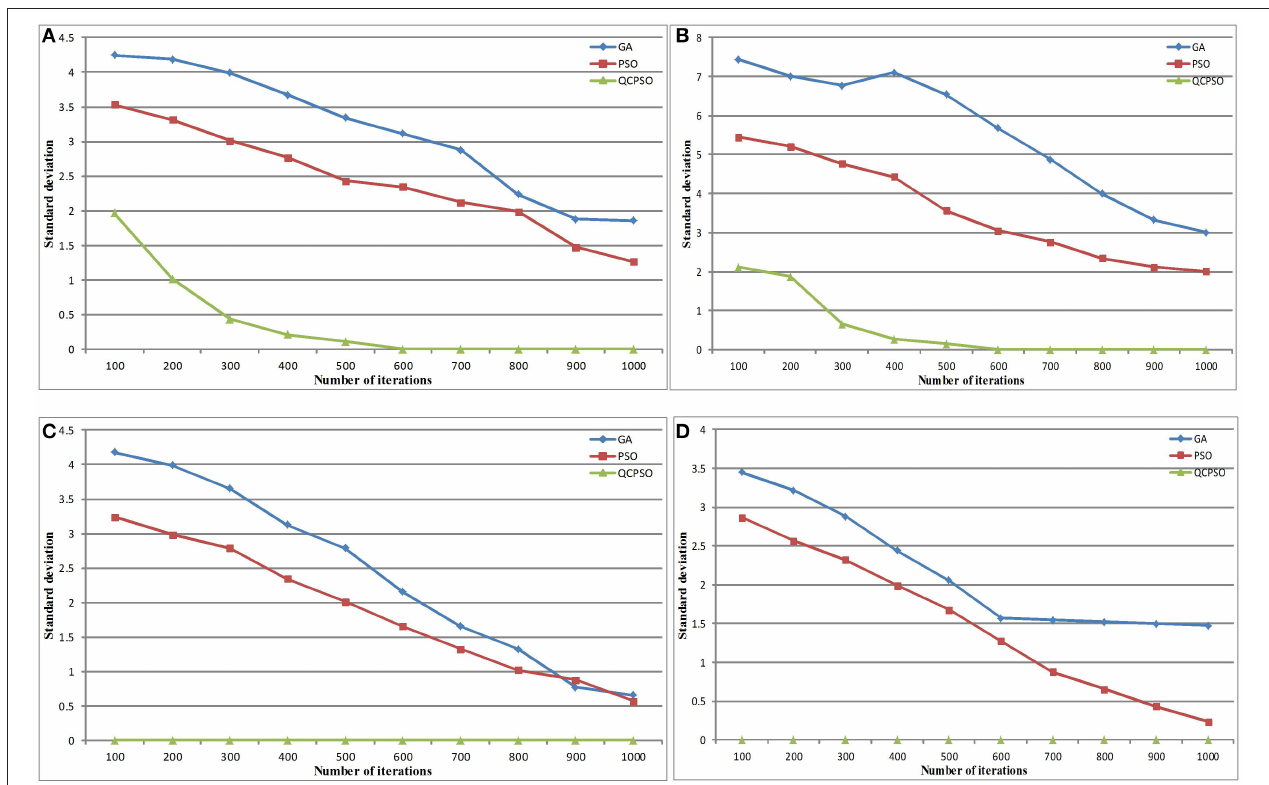
FIGURE 2 | Convergence Comparison of four Functions ( D